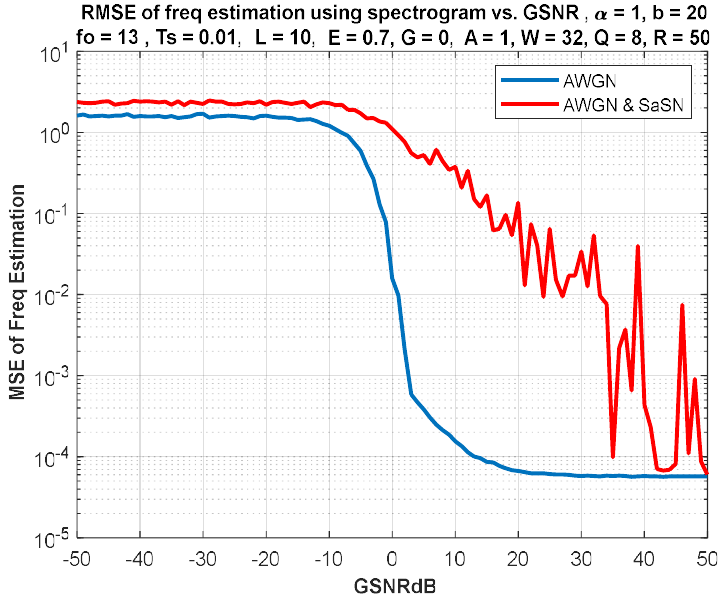
Figure 27. MSE versus GSNR for TFD of noisy LFM signal by spectrogram, where α = 1 and b = 2.